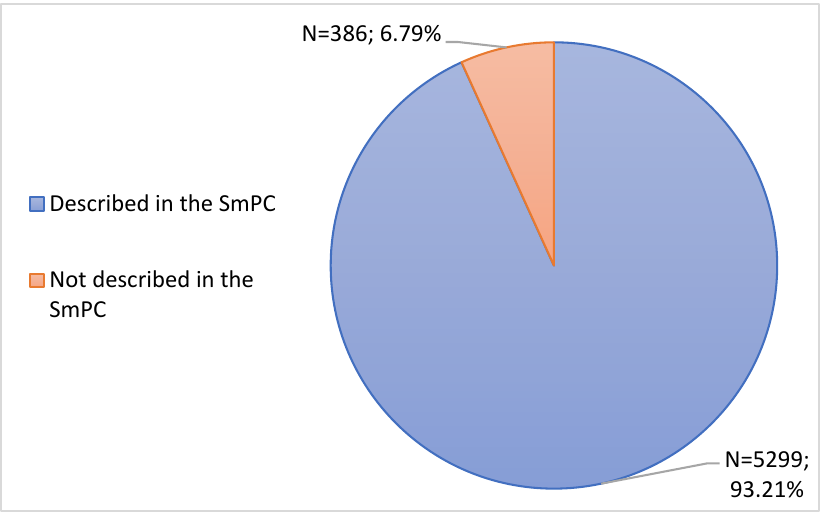
Figure 6. Characterization of Adverse Drug Reactions according to the description in the SmPC. ADRs not described in the SmPC were grouped according to 2 categories: “Degree of Causality Studied” and “Degree of Causality not studied”. The category of “Degree of Causality Studied” obtained the most prominence (61.66%; n = 238) (Figure 7).